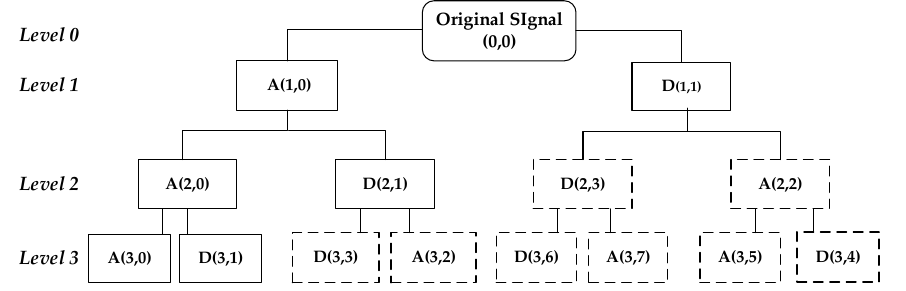
Figure 1. Three-layer structure of wavelet packet decomposition based on frequency order.